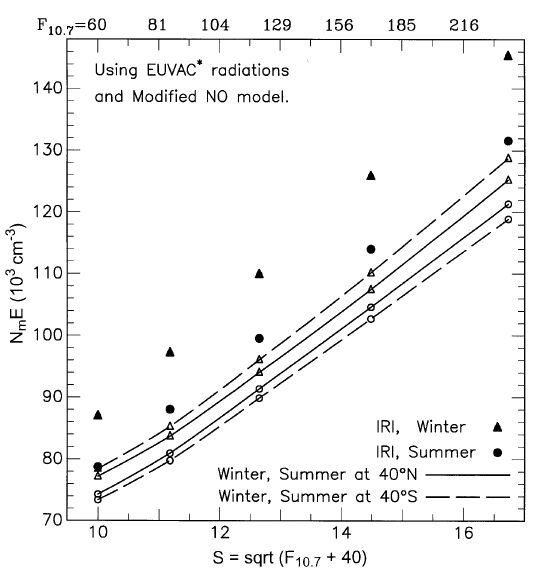
Fig. 10. Calculated values of N (cid:109) E , for the same conditions as in Fig. 9, using a modified model for the seasonal changes in NO. Continuous and broken lines are for latitudes of 40 ° N and 40 ° S,